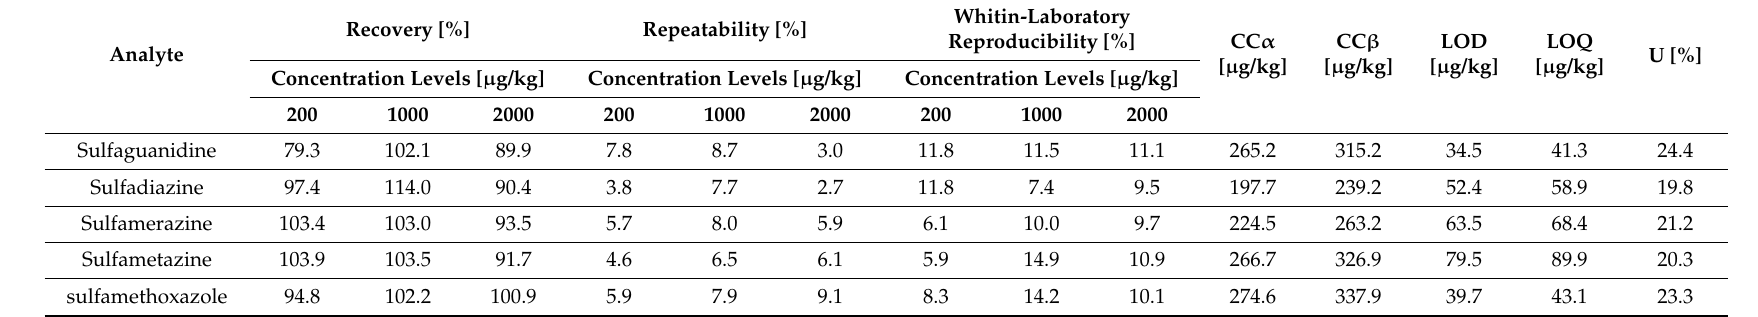
Table 1. Validation parameters of the high-performance liquid chromatography-fluorescence detection(HPLC-FLD) method.